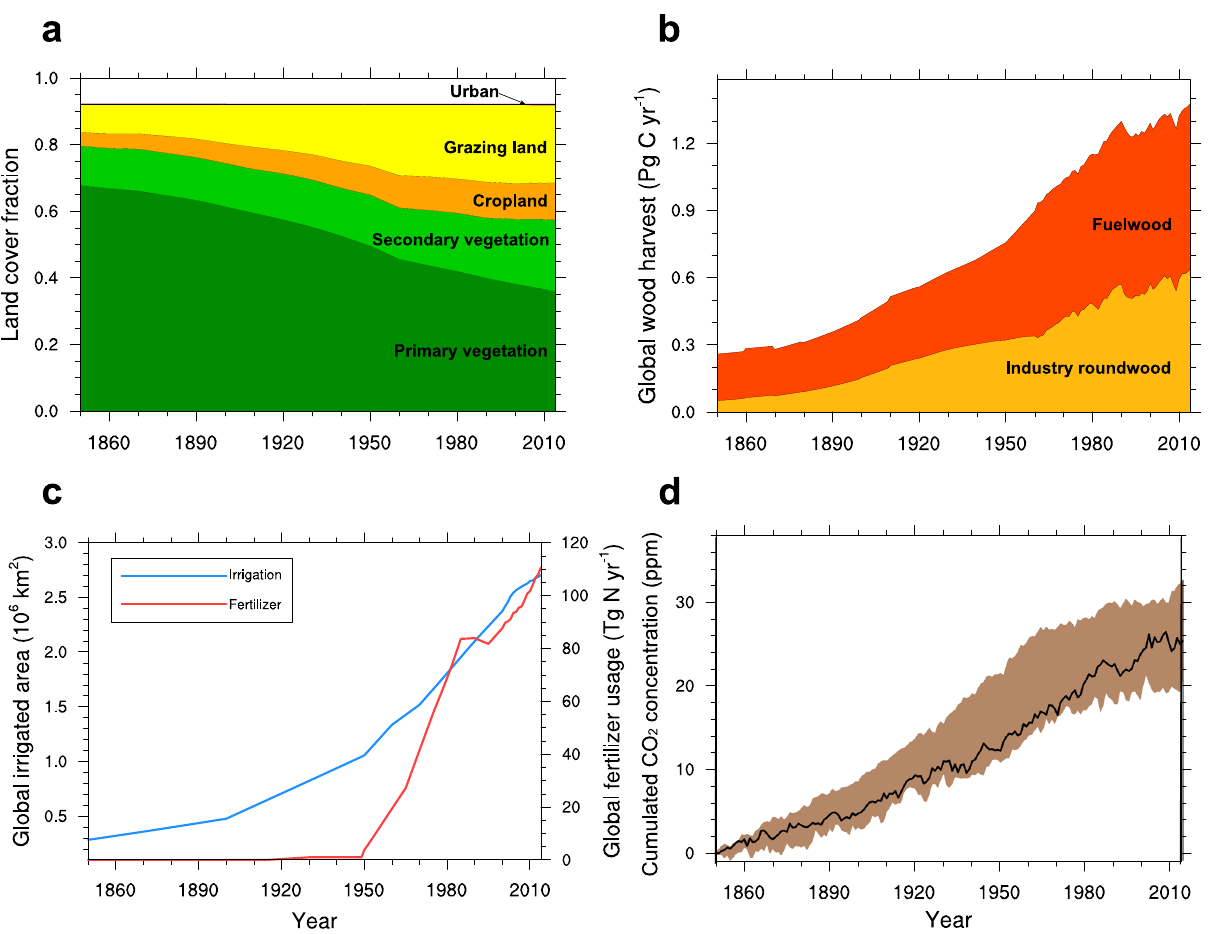
Fig. 1 Global historical land-use and land-cover change (LULCC) and the resulting cumulative increase in atmospheric CO 2 concentrations from 1850 to 2014. a Land-cover fractions (relative to global land except for Antarctica) of primary vegetation (dark green), secondary vegetation (light green), cropland (orange), grazing land (yellow), and urban land (pink). The fractions of the fi ve land-cover types add up to less than 1 due to the coverage of ice and water (shown in the white area). b Annual global wood harvest (Pg C yr − 1 ) for fuelwood (red) and industrial roundwood (yellow). c Global irrigated area (blue line, 10 6 km 2 ) and annual fertilizer usage (red line, Tg N yr − 1 ). a – c are based on the LUH2 dataset 4,43,46 . d LULCC-induced cumulative increase in atmospheric CO 2 concentrations (ppm). The black line and corresponding brown shading denote the median and 25 – 75th percentile range of ensemble